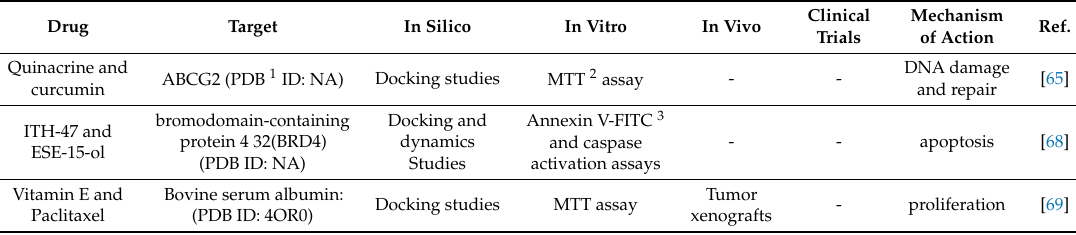
Table 4. Characteristics of studies reported in the review categorized as “combination of drugs” used in metastatic breast cancer. The table reports the drug, its target with PDB ID, in silico / in vitro / in vivo methods used to test the drug, clinical trials, mechanism of action and